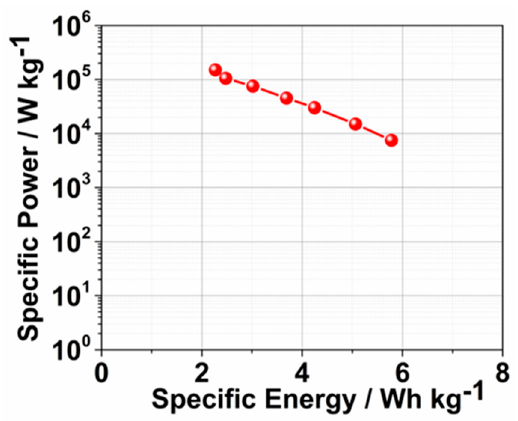
Figure 10. The Ragone plot of MnPO 4 · H 2 O nanowire/GO composite material in the symmetric double-electrode system.